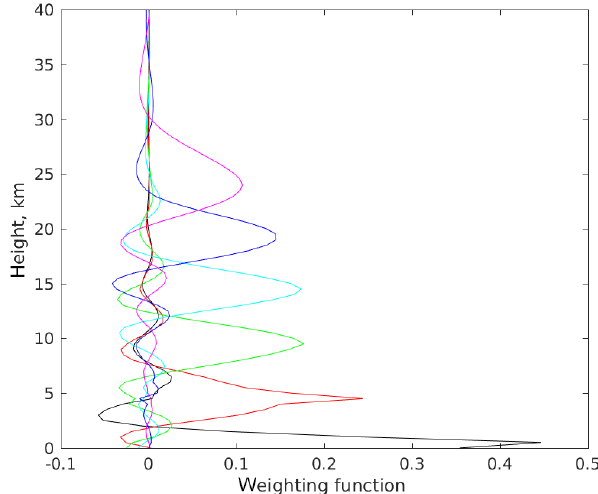
Figure 3. Weighting kernels of wind retrievals according to Eq. (10) as functions of altitude. Kernels corresponding to reference heights of 0, 5, 10, 15, 20, and 25km are